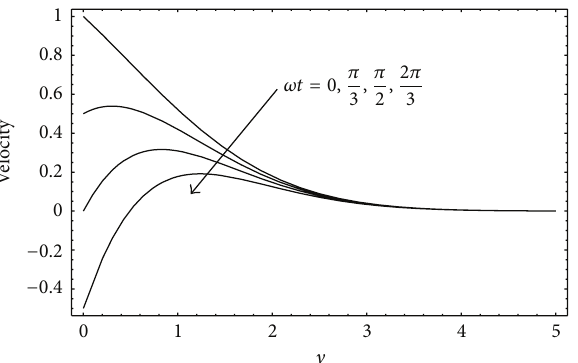
Figure 7: Velocity profiles for different values of Sc when 𝑡 = 0.4, 𝑅 = 2, Pr = 0.71, Gr = 5, Gm = 2, 𝛾 = 0.1 , and 𝜔 = 𝜋/3 .